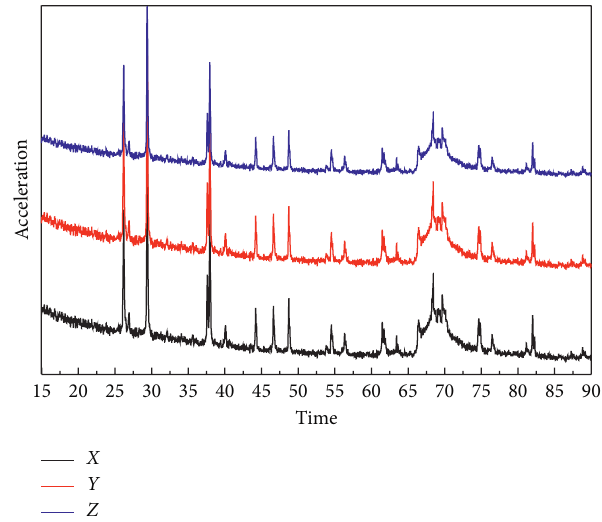
Figure 7: Motion estimation model for single-objective tracking- based augmented multiobjective tracking method and boundary- box regression.